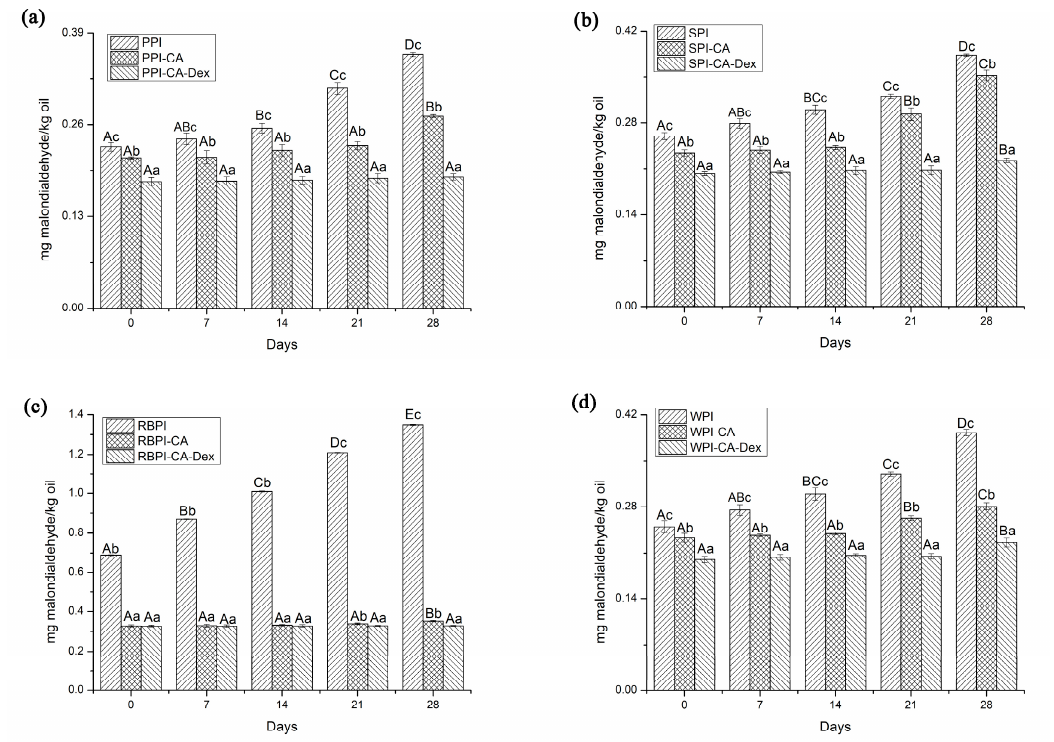
Figure 7. The thiobarbituric acid-reactive substances (TBARS) values of nanoemulsions stabilized by NP, PC, and PCD samples under different storage weeks. ( a ) represented the TBARS values of nanoemulsions stabilized by PPI, PPI-CA and PPI-CA-Dex under different storage weeks; ( b ) represented the TBARS values of nanoemulsions stabilized by SPI, SPI-CA and SPI-CA-Dex under different storage weeks; ( c ) represented the TBARS values of nanoemulsions stabilized by RBPI, RBPI-CA and RBPI-CA-Dex under different storage weeks; ( d ) represented the TBARS values of nanoemulsions stabilized by WPI, WPI-CA and WPI-CA-Dex under different storage weeks. A–D represented that there were statistically differences ( p < 0.05) in TBARS values in different storage time of same samples, a–c represented that there were statistically differences ( p < 0.05) in TBARS values in same storage time of different samples.